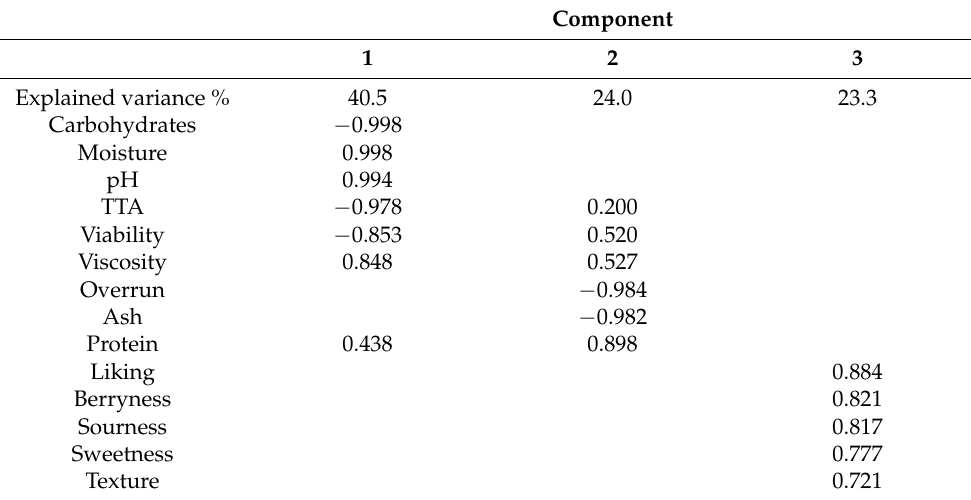
Table 3. Rotated component matrix from the Principal Component Analysis (PCA) and the percentage of variance explained by each component. Loadings < 0.2 are hidden from the